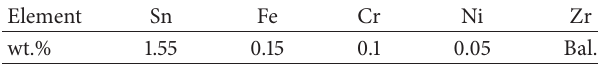
Table 1: Chemical composition of zircaloy-4. Element Sn Fe Cr Ni Zr wt.% 1.55 0.15 0.1 0.05 Bal. (Fe + Cr + Ni =